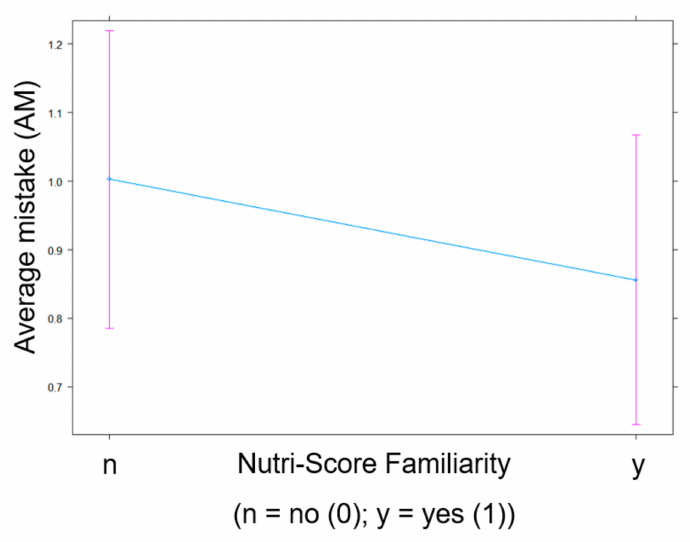
Figure 2. Impact of Nutri-Score Familiarity (n = no, not (very) familiar (0); y = yes, (very) familiar (1)) on AM in the healthfulness estimation exercise.